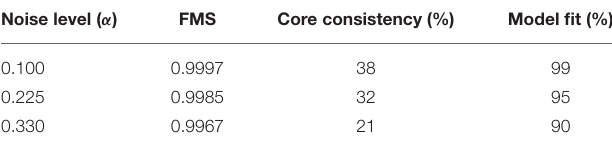
TABLE 1 | FMS, core consistency, and model fit for 4-component CP models of noisy LFP tensors. Noise level ( α )